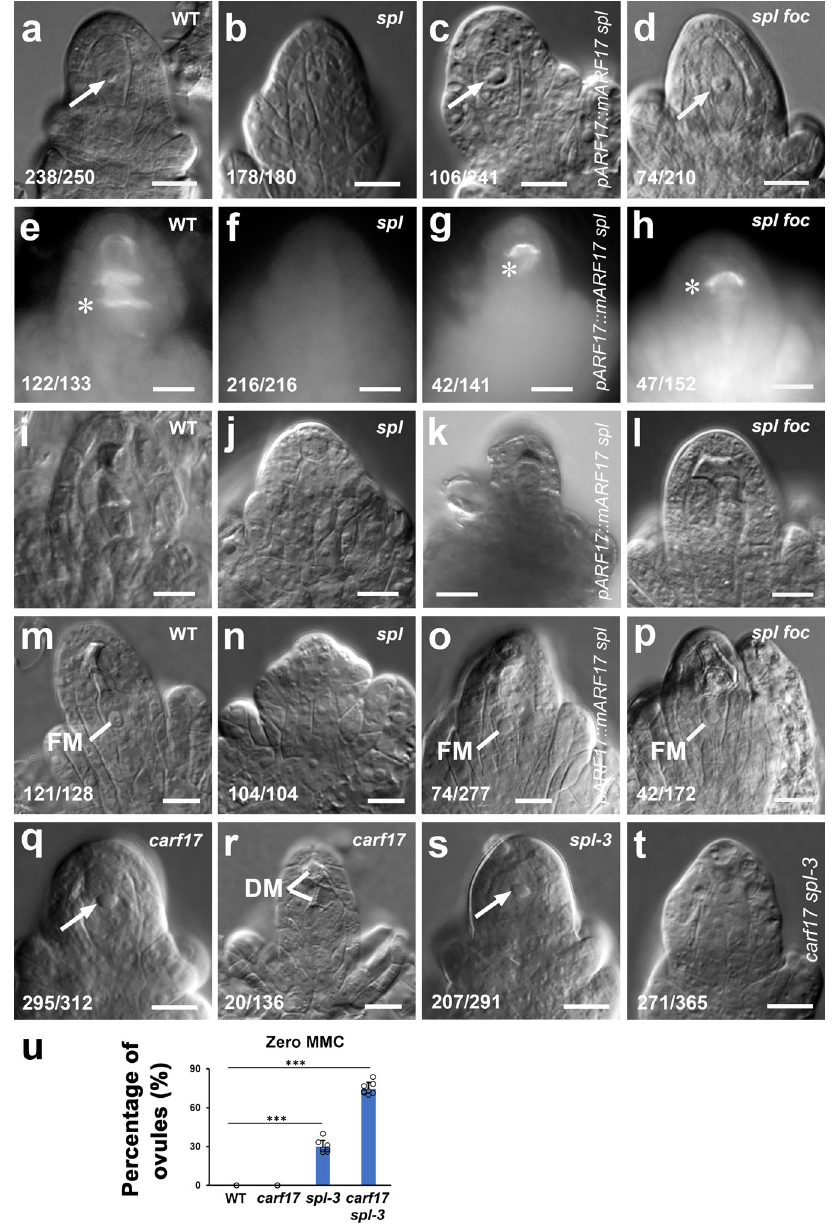
Fig. 3 | ARF17 controls MMC speci fi cation. a – l Overexpression of ARF17 in the spl mutant rescued the MMC formation. DIC images showing one MMC in WT ( a ,arrow), noMMCin spl ( b ),one MMCLin pARF17::mARF17spl ( c , arrow),and one MMCL in spl foc ( d , arrow) ovules. e – l Callose deposition (denoted by white asterisks) displaying one MMC undergoing meiosis in WT ( e ), pARF17::mARF17 spl ( g ),and splfoc ( h )ovules,butnomeiosisoccurrenceinthe spl ovule( f ). e – h